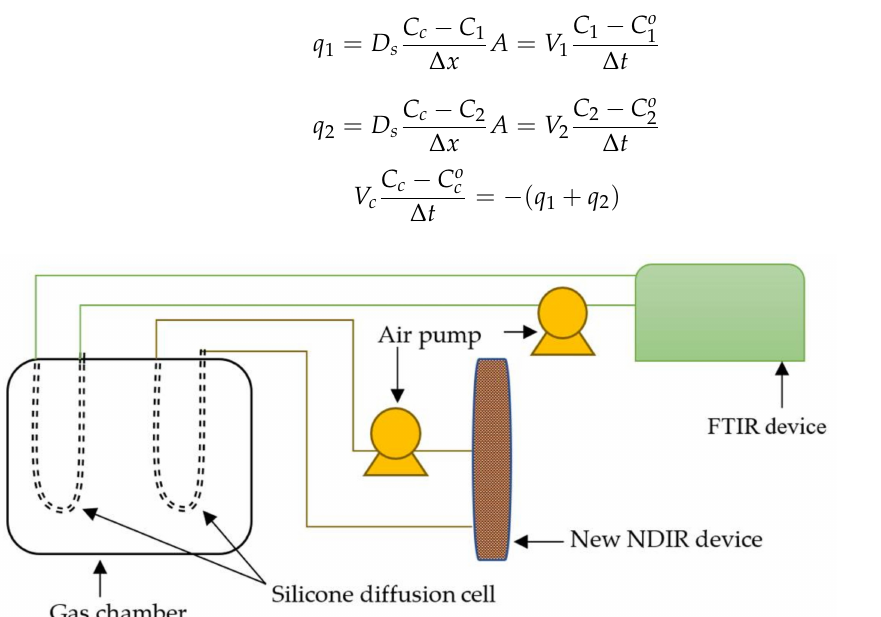
Figure 2. Experimental setup for determining the diffusion coefficient of the silicone diffusion cell. q 1 : rate of the diffused gas volume from container to system 1 (10 − 6 cm 3 s − 1 ); q 2 : rate of the diffused gas volume from container to system 2 (10 − 6 cm 3 s − 1 ); D s : gas